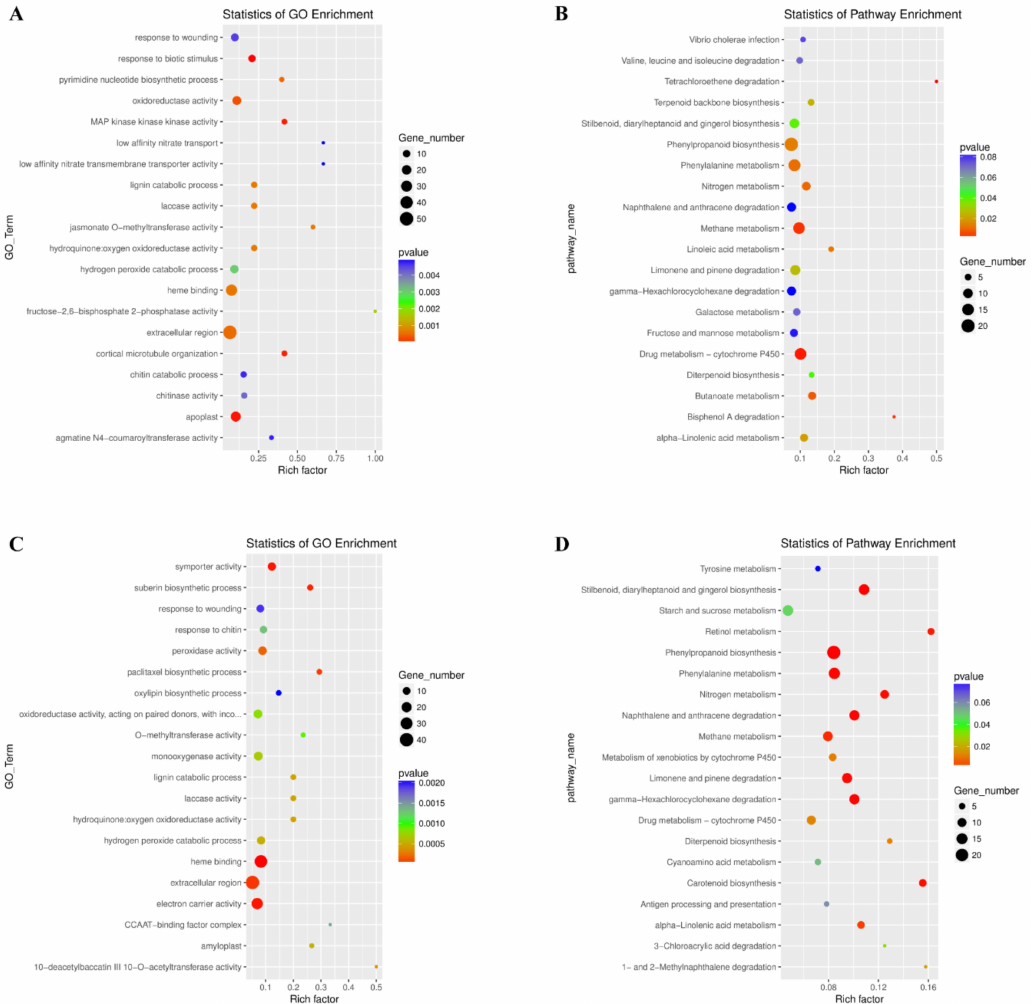
Figure 3. The 20 most enriched Gene Ontology (GO) terms ( A and C ) and Kyoto Encyclopedia of Genes and Genomes (KEGG) pathways ( B and D ) for Nipponbare rice roots infected by Meloidogyne incognita at 6 dpi ( A and B ) and 18 dpi ( C and D ). “Rich factor” indicates the ratio between the number of DEGs and the number of genes in this pathway. The higher the rich factor, the greater the degree of enrichment.